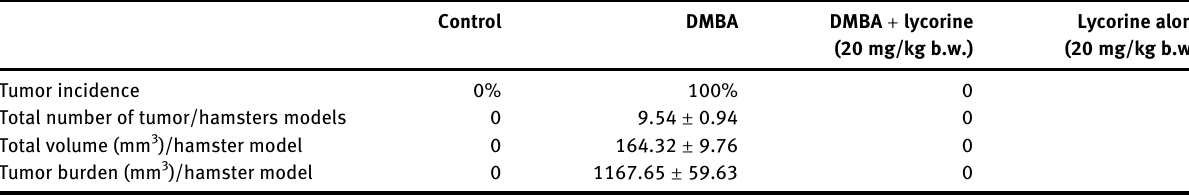
Control DMBA DMBA + lycorine